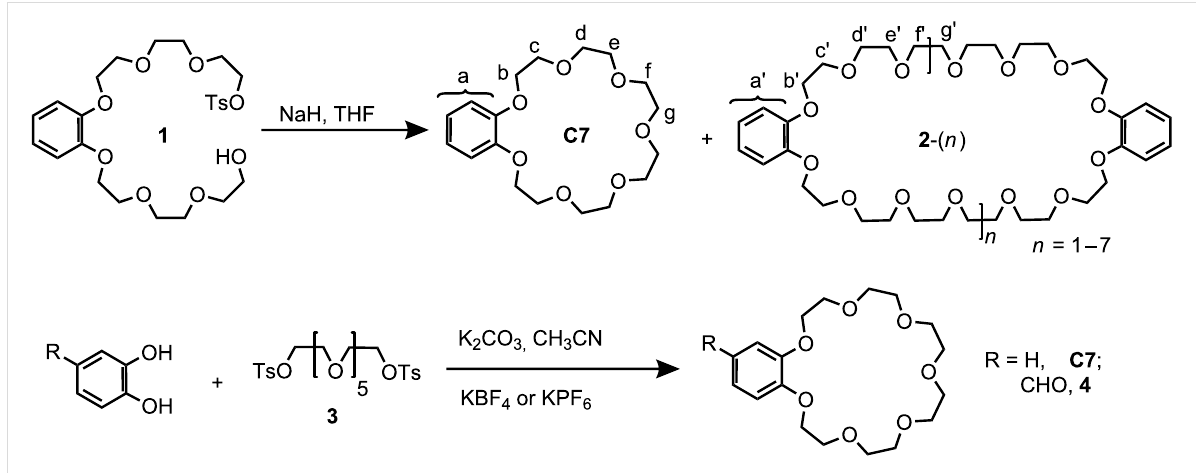
Scheme 1: Two synthetic procedures for the preparation of benzo-21-crown-7 ( C7 ) and its formyl analogue 4 : Top: The non-templated macrocycliza- tion of 1 yields a mixture of crown ethers of different sizes. Bottom: With K + as the template, benzo-21-crown-7 can be obtained in much better yields.